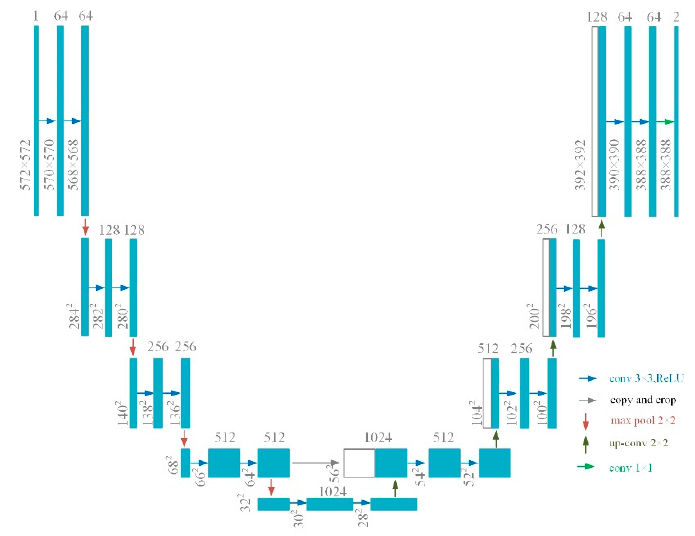
Figure 6. The structure diagram of U-Net